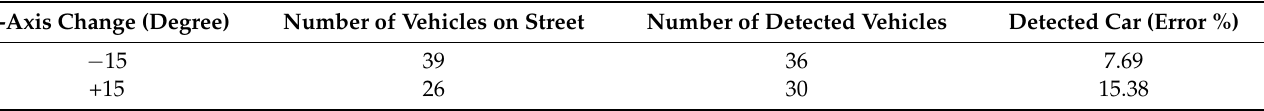
Table 8. Vehicle detection accuracy on the UAV X-axis degree variation.